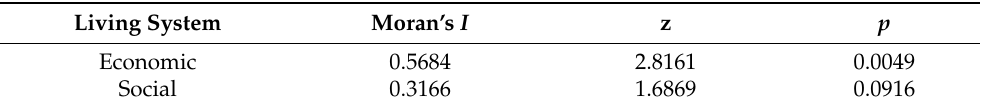
Note: The coordination level corresponding to the colors in the table refers to the grading standard in Table 4. Table 8. Moran’s I Table of Sustainable Livelihood Capital of Farmers in Ecological Migration Area of Liujiaxia Reservoir